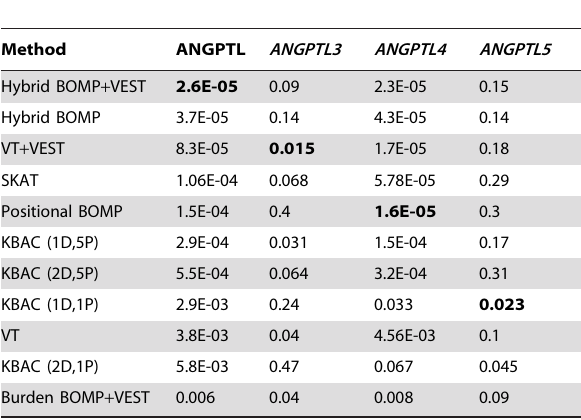
Table 2. Dallas Heart